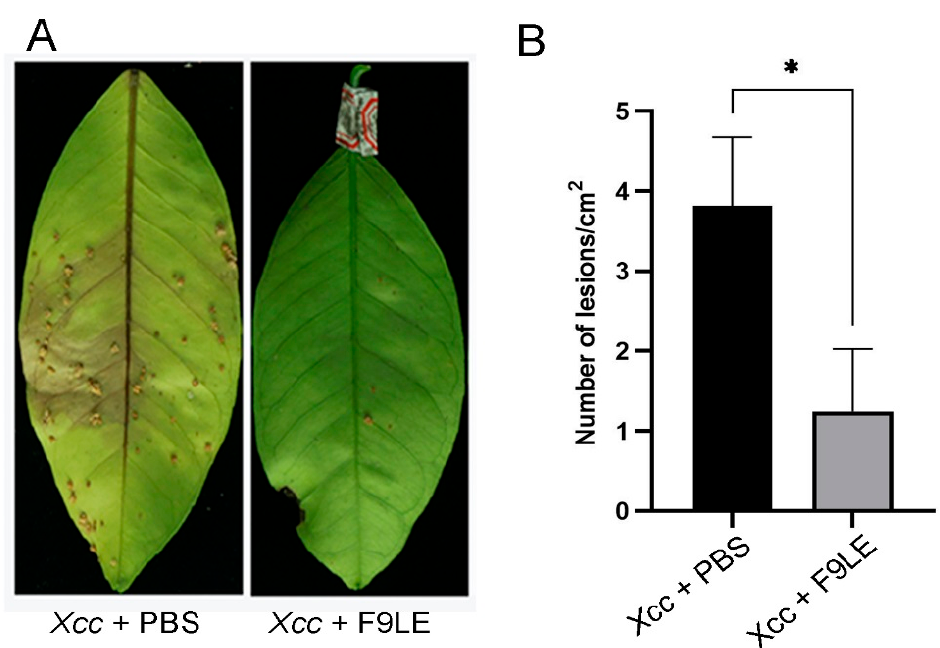
Figure 2. Biological control efficiency of F9 lipopeptide extract (F9LE) on Xcc jx-6 under greenhouse conditions. ( A ) The method of spray inoculation was used to control citrus canker in pots. The same amount of Xcc jx-6 suspension was sprayed on citrus leaves in advance, bagged after air drying and sprayed with 244 µg/mL F9LE or control PBS after 24 h. ( B ) Quantification of canker lesions in citrus leaves. Mean values were analyzed and separated by Tukey’s HSD test at * p < 0.05 after one-way ANOVA. Error bars represent standard deviation.